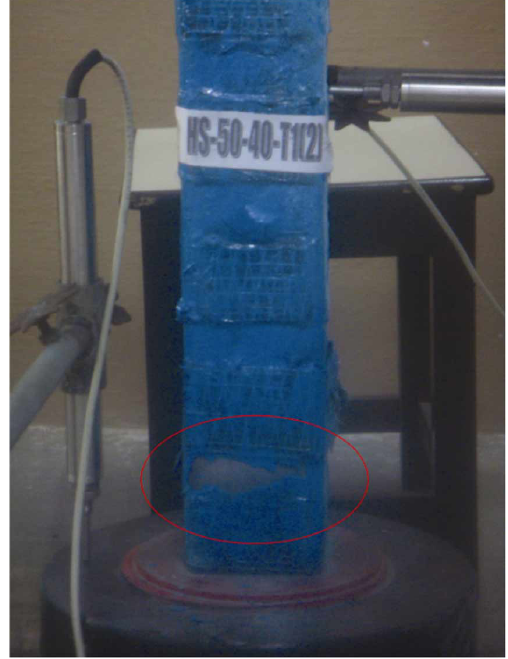
Fig. 10. The column HS-50-40-T3(2) failed by rup- ture of fibre occurred at top edge of the columns due to outward buckling of steel tube at the load of 1022 kN. In the overview, when increasing the number Fig. 7. Failure mode of column HS-50-40-T1(2)